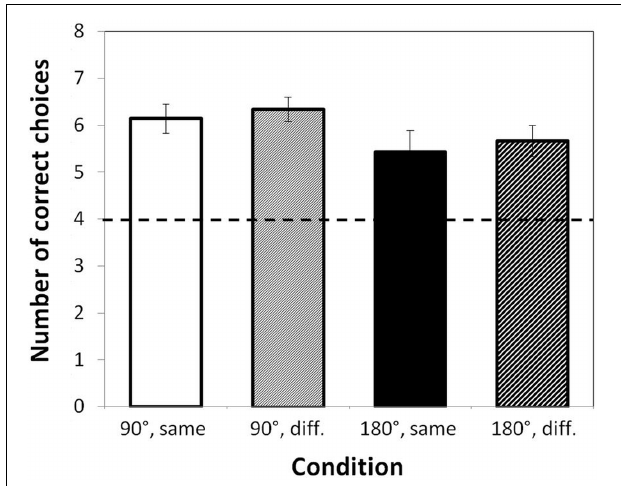
FIGURE 2 | Mean number of correct choices the four conditions (max.: 8). Dashed line: chance level. Same, same colored cups; diff., different colored cups. Error bars indicate standard